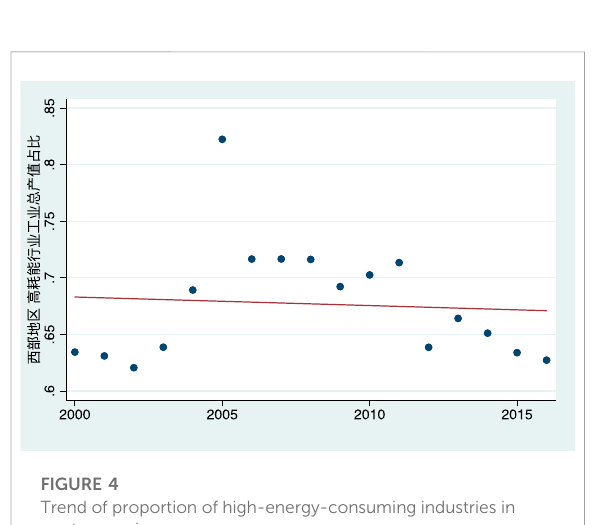
FIGURE 3 Trend of proportion of high-energy-consuming Industries in central Region.